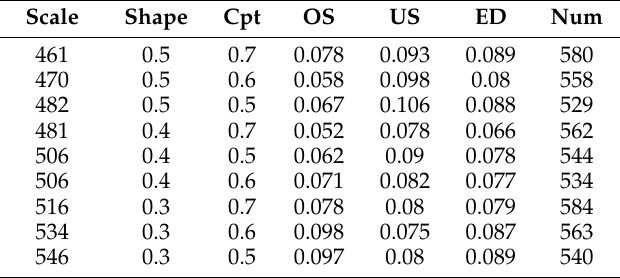
Table 5. Segmentation accuracy metrics for Changwu based on OSRH strategy.